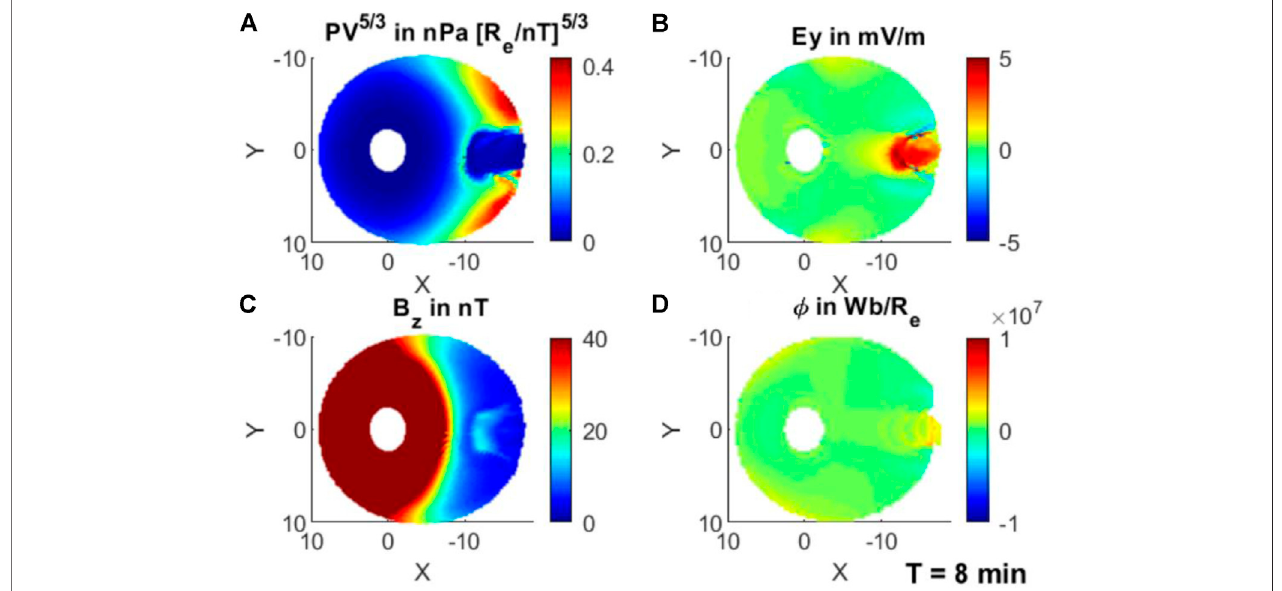
FIGURE2| Singlebubblerunat T (cid:1) 8 min; (A) entropyparameterPV 5/3 innPa[R e /nT] 5/3 ; (B) dawn-to-duskcomponentoftheelectric fi eldE y inmV/m; (C) B Z innT; and (D) cumulative magnetic fl ux transport ϕ in Wb/R e . X and Y are in Earth ’ s radii (R e ) units. The Sun is to the left.